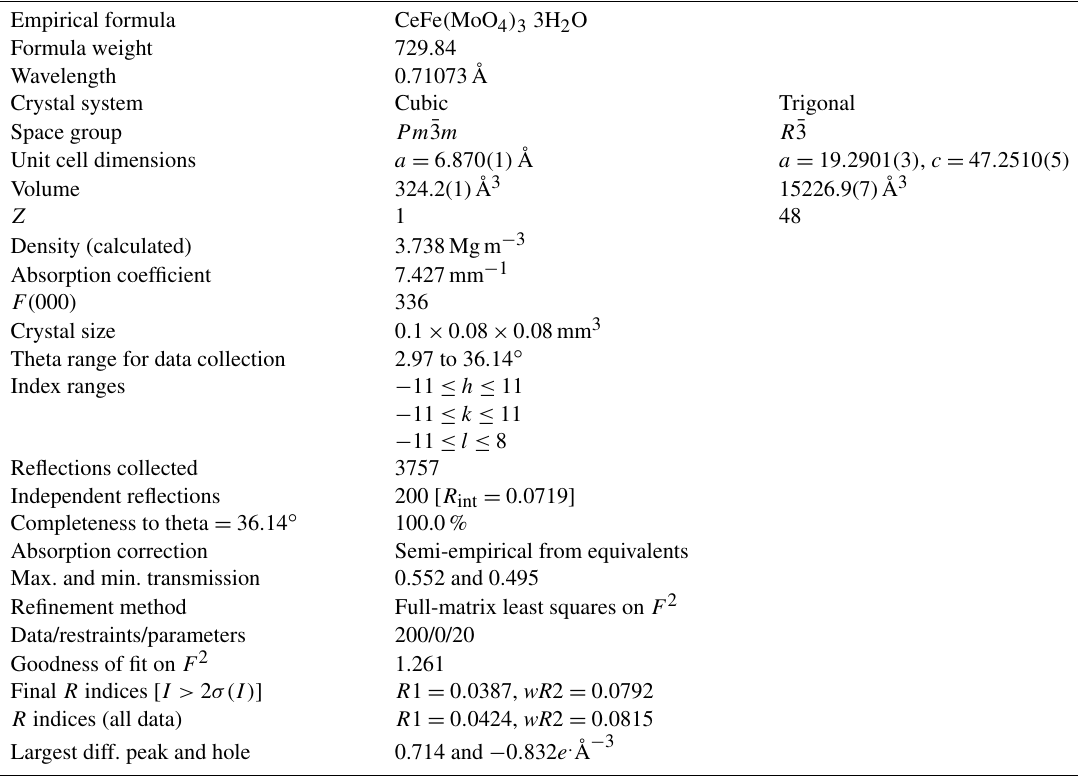
Table 4. Crystal data and structure refinement parameters for tancaite-(Ce). In the second column the available data are reported for the average structure of tancaite-(Ce), whereas in the third column the unit cell and symmetry for the real structure of tancaite-(Ce) are indicated, as refined on the basis of X-ray powder diffraction data.